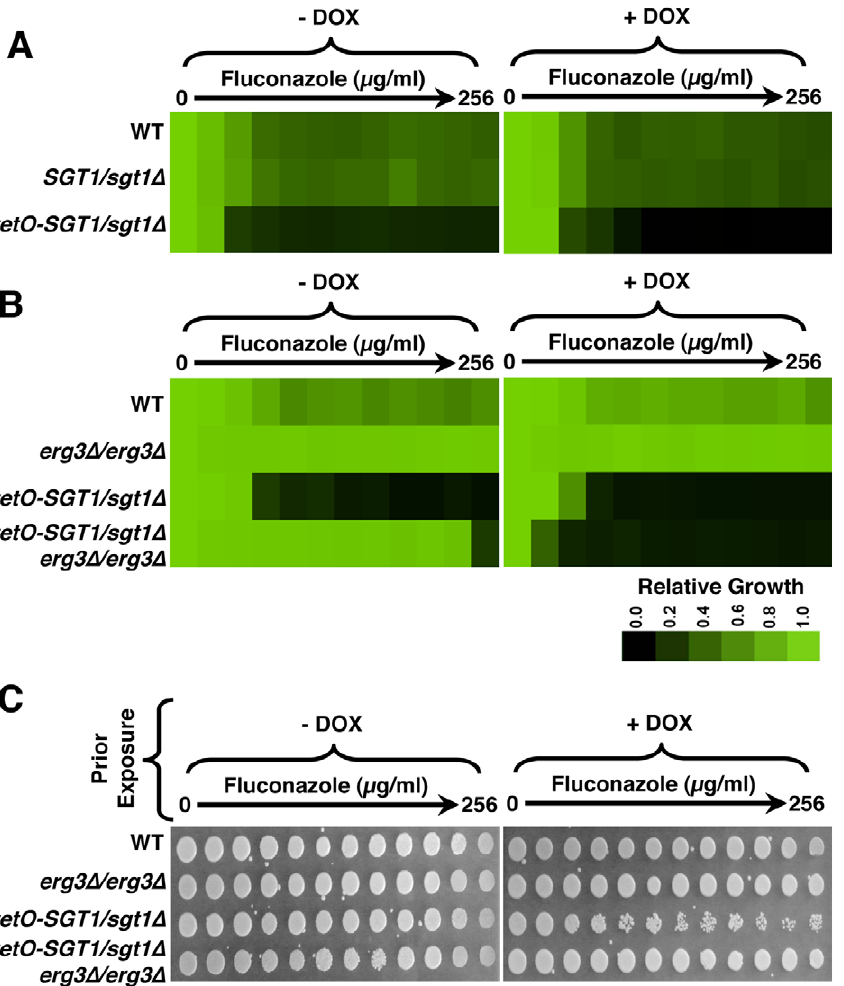
Figure 4. Sgt1 enables basal tolerance and erg3 -mediated resistance to the azoles. (A) Reduced levels of Sgt1 renders cells sensitive to fluconazole in minimum inhibitory concentration (MIC) assays. Assays were performed in YPD medium with a gradient of fluconazole from 0 to 256 m g/ml, in two-fold dilutions, with or without a fixed concentration of 20 m g/ml doxycycline (DOX), as indicated. Growth was measured by absorbance at 600 nm after 48 hours at 30 u C. Optical densities were averaged for duplicate measurements and normalized relative to the no fluconazole control. Data was quantitatively displayed with colour using Treeview (see colour bar). (B) Reduced levels of Sgt1 renders azole-resistant erg3 mutants sensitive to fluconazole in MIC assays. Assays were performed in YPD medium with a gradient of fluconazole from 0 to 256 m g/ml, in two-fold dilutions, with a fixed concentration of 20 m g/ml doxycycline, as indicated. Growth was measured after 72 hours at 30 u C. Data was analyzed as in part A. (C) Cells with reduced levels of Sgt1 remain viable after exposure to fluconazole. MIC assays were performed in YPD medium with a gradient of fluconazole from 0 to 256 m g/ml, in two-fold dilutions, with or without a fixed concentration of 20 m g/ml doxycycline, as indicated. Assays were grown for 48 hours at 30 u C, and cells from the MIC assays were spotted onto YPD medium and incubated at 30 u C for 48 hours before plates were photographed.